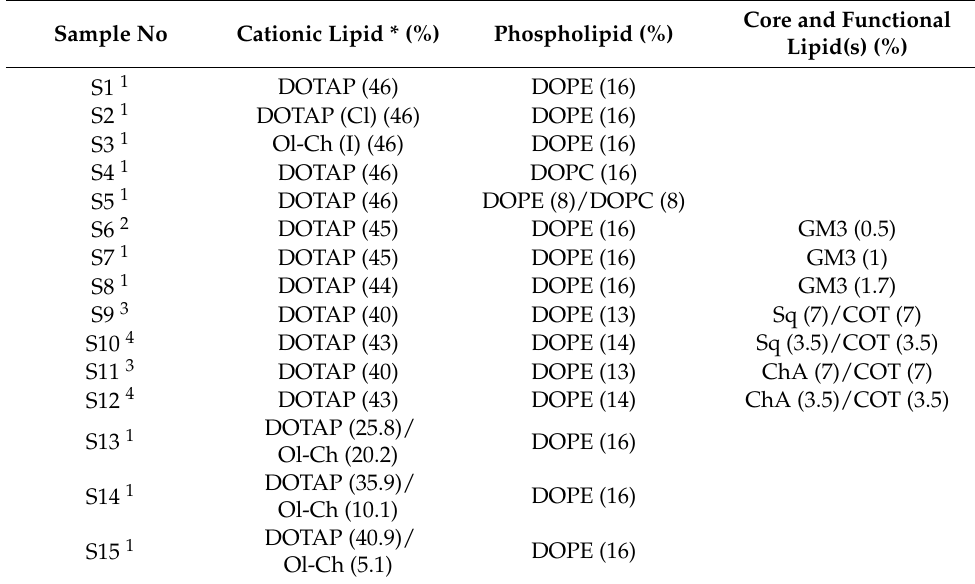
Table 1. Compositions of lipid nanoparticles (mole